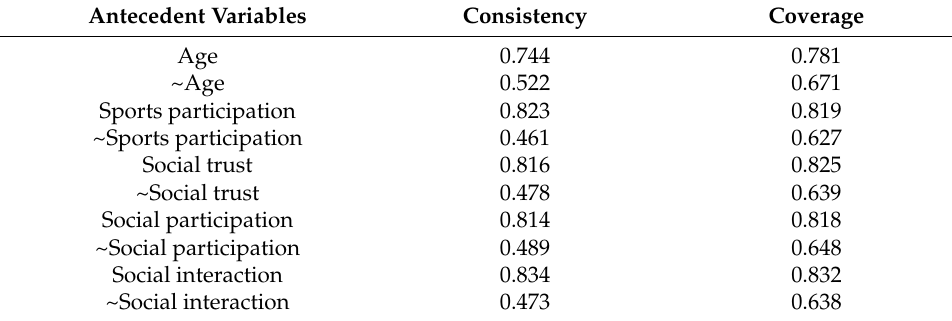
Table 7. Examines the circumstances required for happiness.